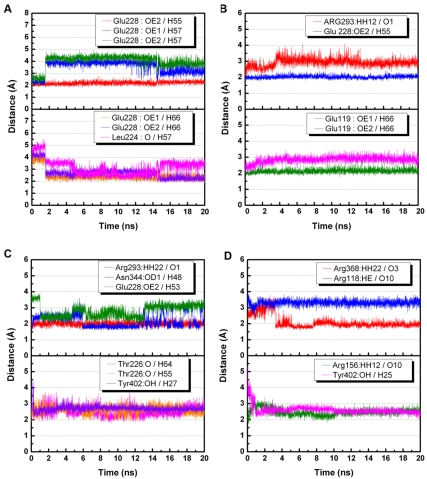
H-bond distance profile between N1 and TCM candidates or Tamiflu®.(A) Xylopine_2, (B) Rosmaricine_14, (C) Rosmaricine_15, and (D) Tamiflu®.